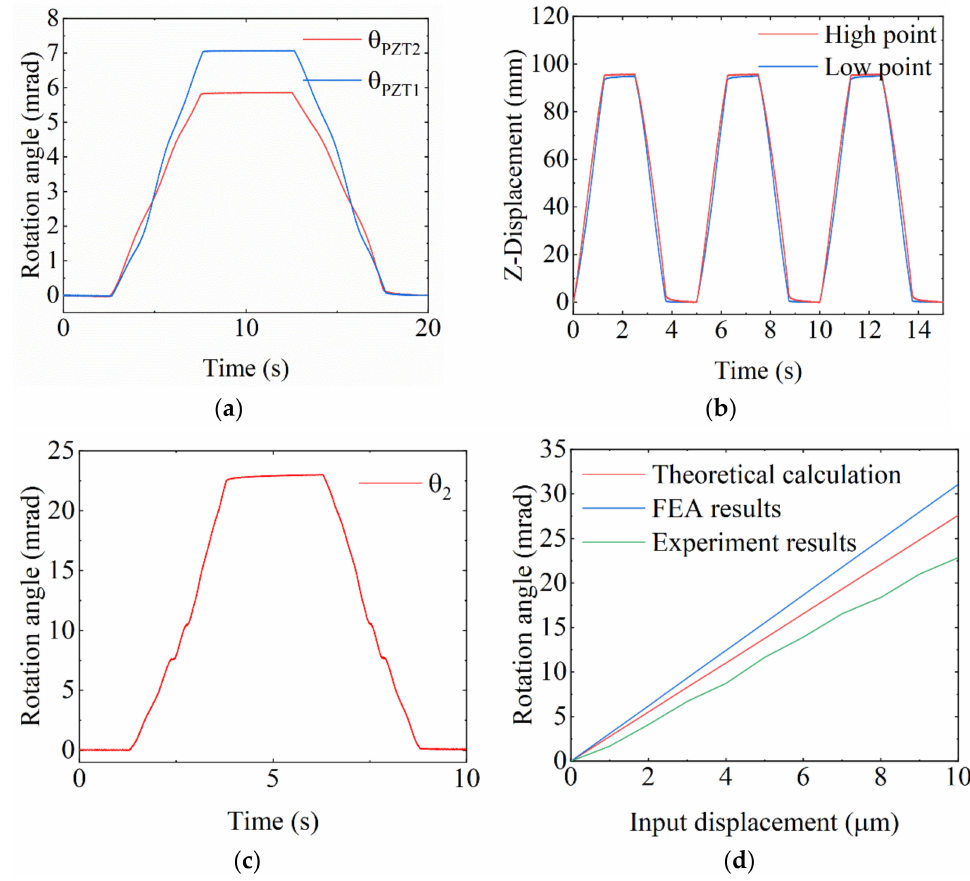
Figure 13. ( a ) Single-drive rotation. ( b ) Double-drive translation. ( c ) Double-drive rotation ( d ) Transmission ratio